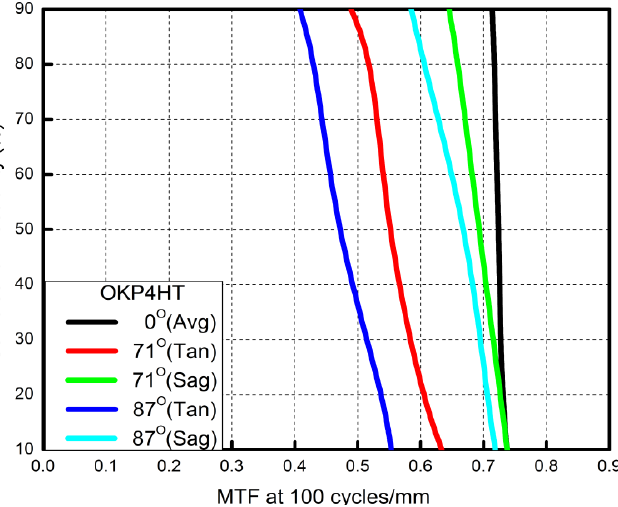
Figure 8. Cumulative probability vs. modulation transfer function (MTF) for a fisheye lens combined with an OKP4HT aspherical lens. For the cumulative probability of 90%, the tangential MTF values at the half FOV for the 0°, 71°, and 87°cases correspond to 0.72, 0.48, and 0.41, respectively.